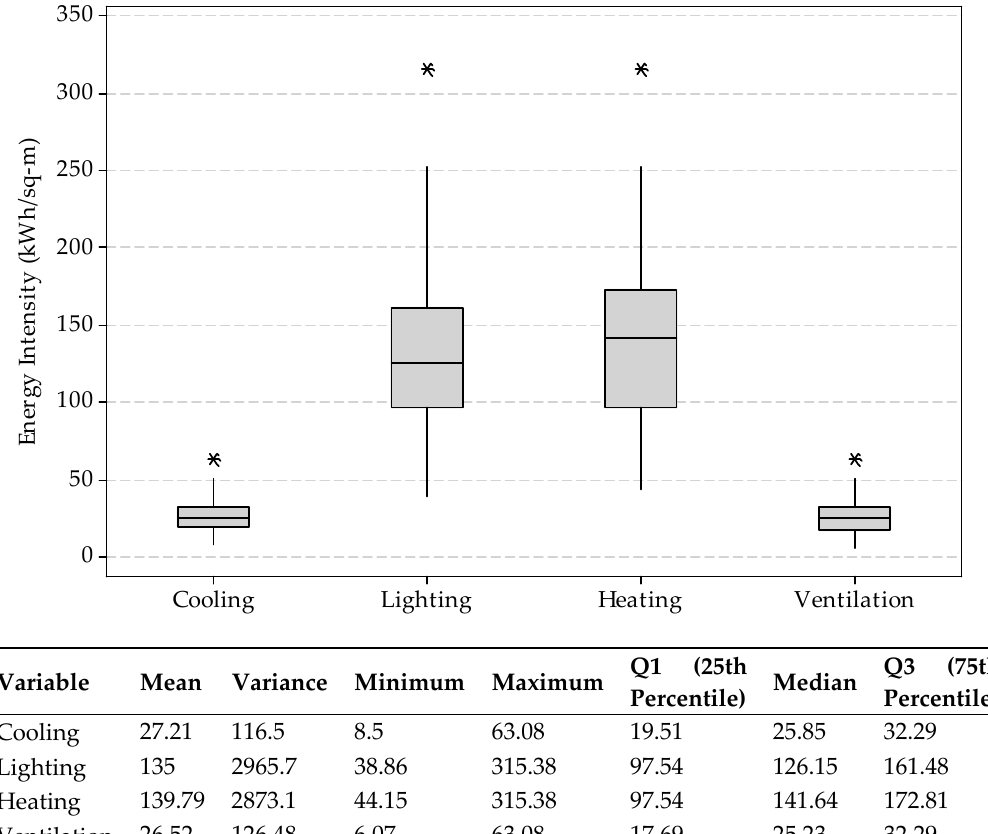
Figure 6. Boxplot and statistical summary of annual non-process energy intensity (kWh/m 2 ) in healthcare facilities (* outlier).